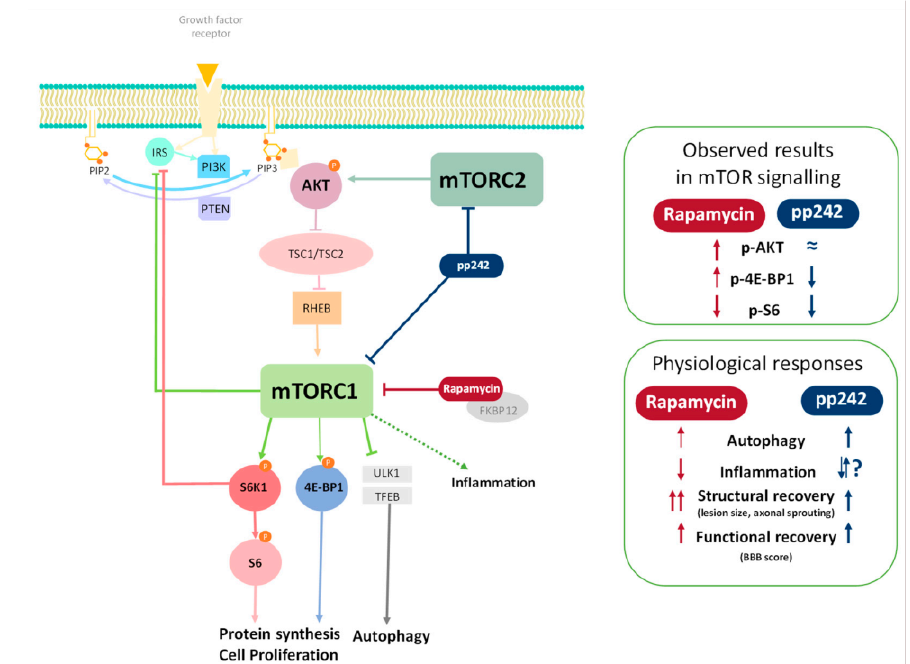
Figure 6. mTOR pathway and its inhibition by rapamycin (RAPA) and pp242 after spinal cord injury (SCI). RAPA, attached to FKBP12, inhibits mTOR complex 1 (mTORC1), which leads to decreased phosphorylation of downstream proteins S6, eukaryotic translation initiation factor 4E- binding protein 1 (4E-BP1), autophagy activation through ULK1 and transcription factor EB (TFEB), and reduced inflammation. A negative feedback loop through disinhibition of insulin receptor substrate-1 (IRS) is also induced with RAPA inhibition, which leads to activation of AKT, through phosphatidylinositol 4,5-bisphosphate (PIP2) conversion to phosphatidylinositol (3,4,5)-trisphosphate (PIP3) by phosphoinositide 3-kinase (PI3K). Akt inhibits tuberous sclerosis complex (TSC), which leads to disinhibition of the small GTPase RHEB (Ras homolog–mTORC1 binding) and RHEB activates mTORC1. Inhibition of mTORC1 and mTOR complex 2 (mTORC2) by pp242 leads to inhibition of AKT and, therefore, more effective inhibition of the mTOR pathway. Panels on the right display observed changes in protein modifications and physiological responses during inhibition of the mTOR pathway after SCI compared to vehicle treated controls. Phosphatase and tensin homolog (PTEN); ribosomal protein S6 kinase 1